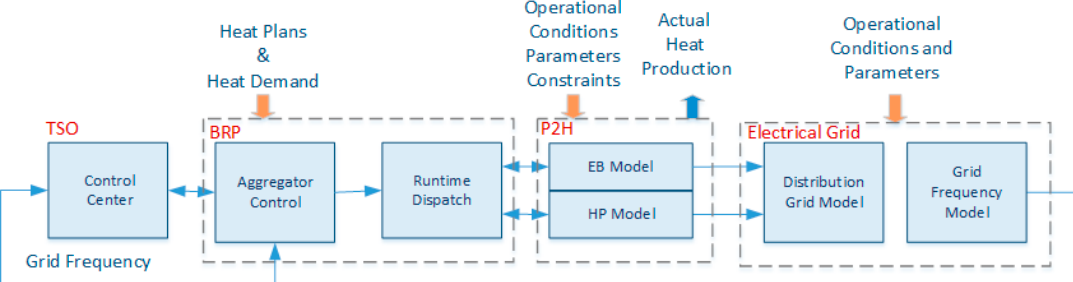
Figure 6. Generic model architecture for frequency regulation studies.